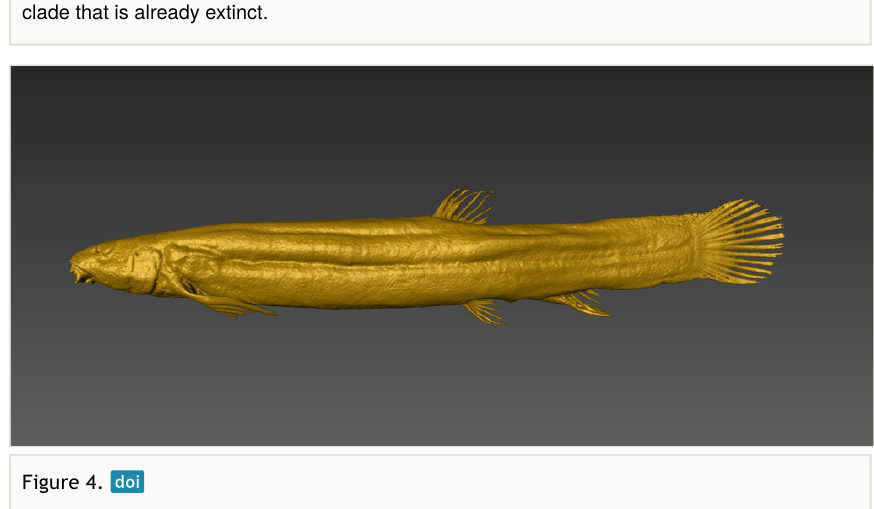
A 3D model of the surface of Misgurnus anguillicaudatus (Clade B1)